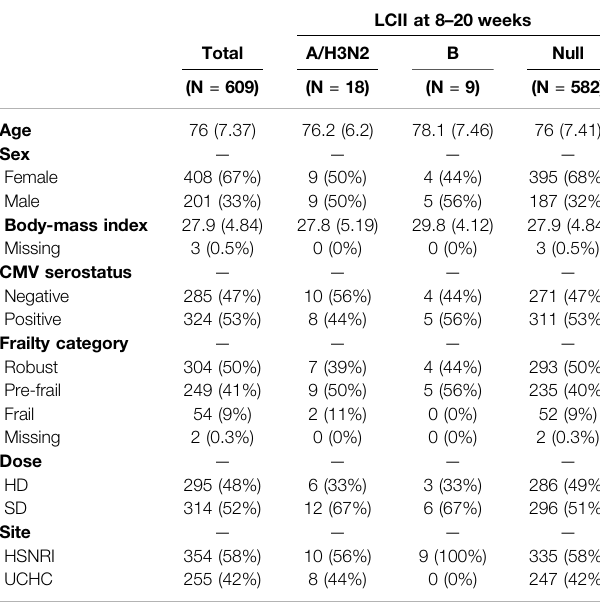
Supplemental Table S2 ), consistent with an in fl uenza A type-speci fi c GrB response to natural infection.